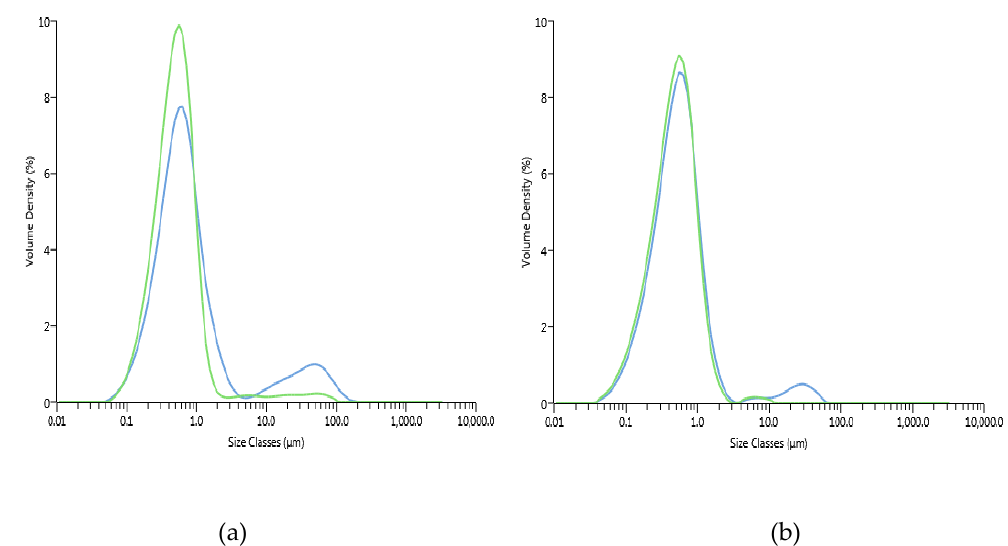
Figure 5. Distribution size of oil droplets of emulsions from control UF-retentates ( a ) and UF-retentates of plasma from pressure-treated granules ( b ) emulsions at 0 h after preparation, without tris / glycine / SDS (blue line) and with SDS added (green line).